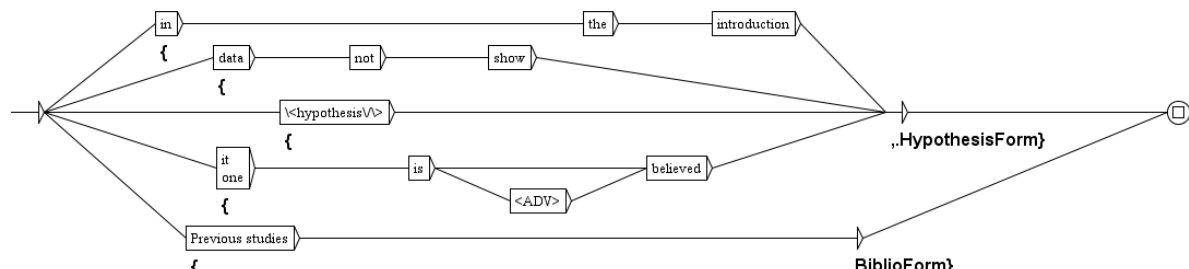
Figure 8. The graph to identify the status of an experimental fact.